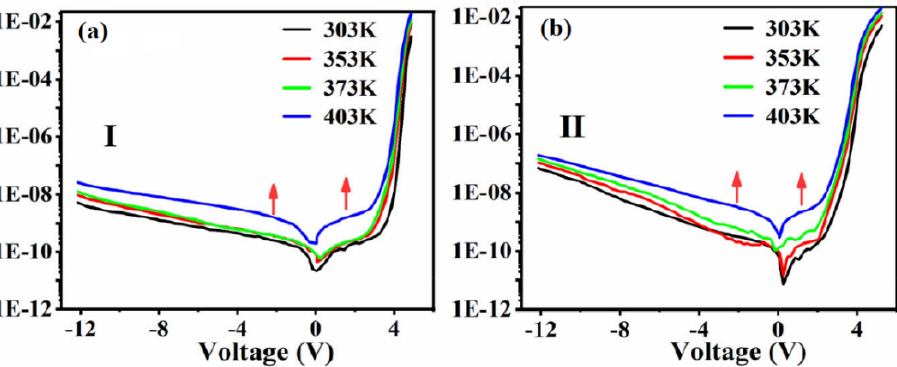
Figure 28. ( a ) The I-V curves of the 276 nm LED and ( b ) 306 nm LED. [56] Copyright 2022, Springer.